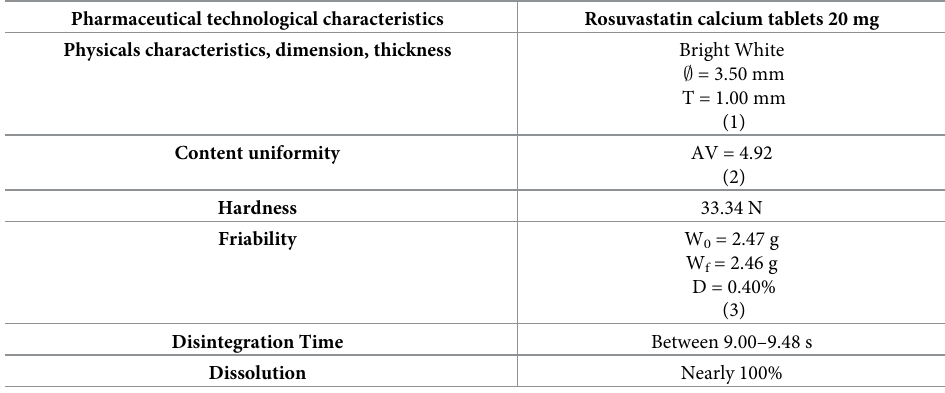
Table 4. Pharmaceutical technological characteristics of rosuvastatin tablets.